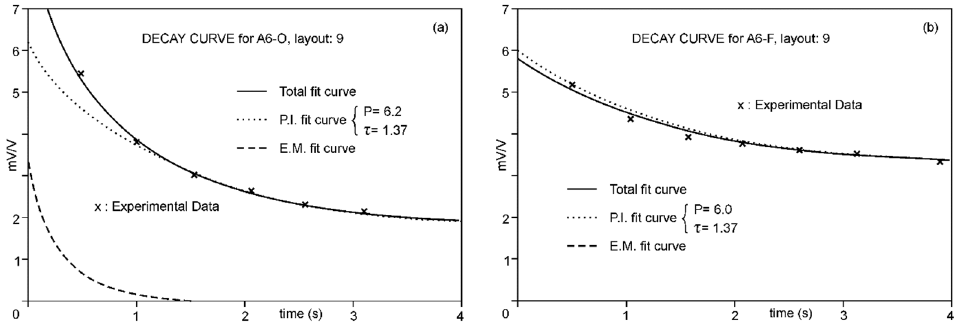
Figure 4. ( a ). Decay curve of sounding A6-O, station 9. ( b ). Decay curve of sounding A6-F, station